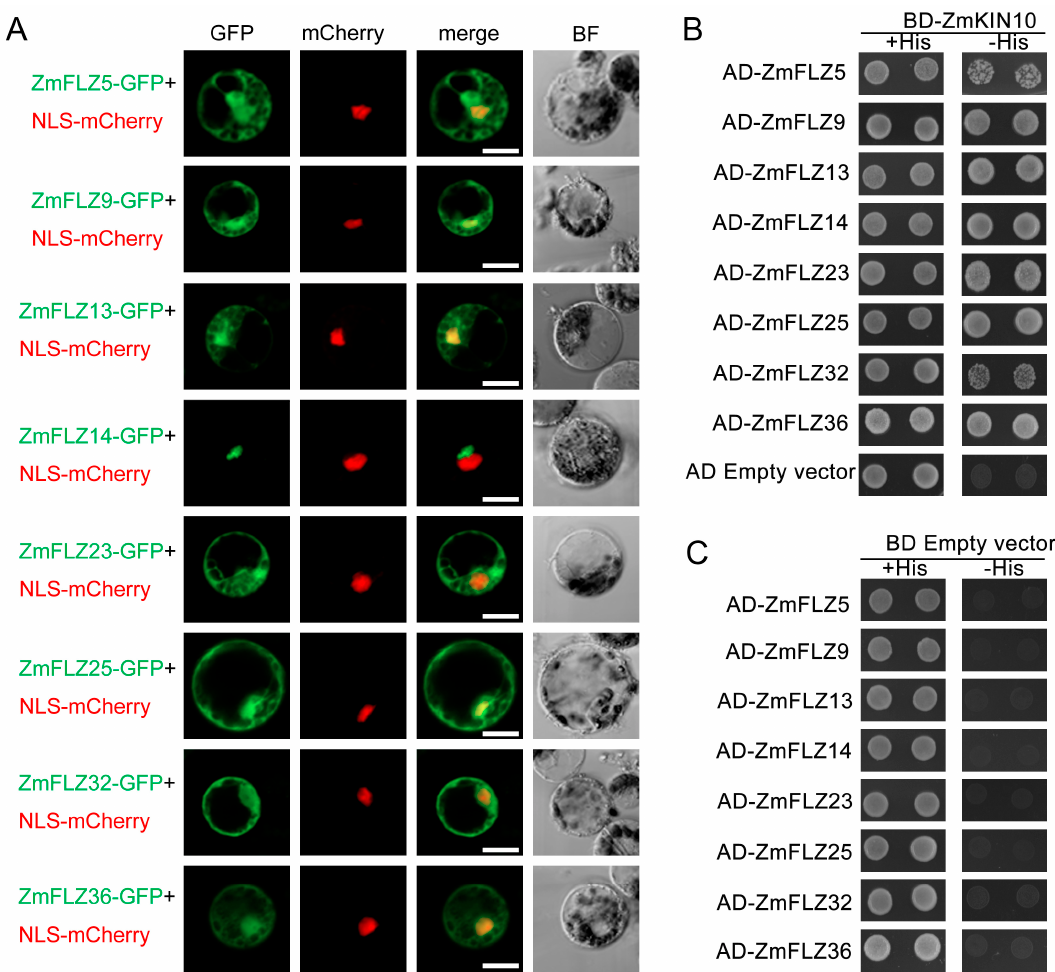
Figure 3. Subcellular localization of the eight selected ZmFLZs and ZmFLZs interaction with ZmKIN10 by Y2H assay. ( A ) ZmFLZs-GFP fusion constructs were used to determine the subcellular localization of ZmFLZs in the protoplast cells isolated from maize leaves. NLS-mCherry was used as a nuclear marker. Fluorescent images of GFP and mCherry were captured with a confocal laser scanning microscopy and shown in green and red, respectively. Scale bars = 25 μ m. ( B , C ) Yeast two hybrid analysis of the binary interactions between the eight selected typical ZmFLZs and ZmKIN10.